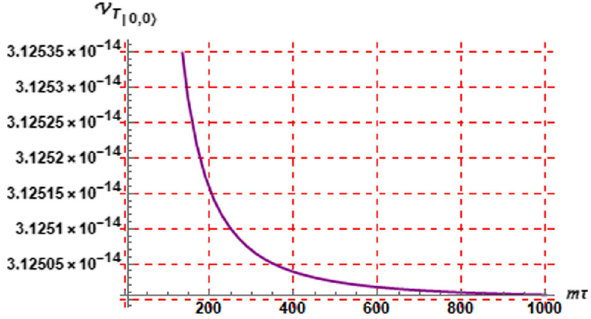
Fig. 1 Density fluctuations in TMV states V T | tion of m